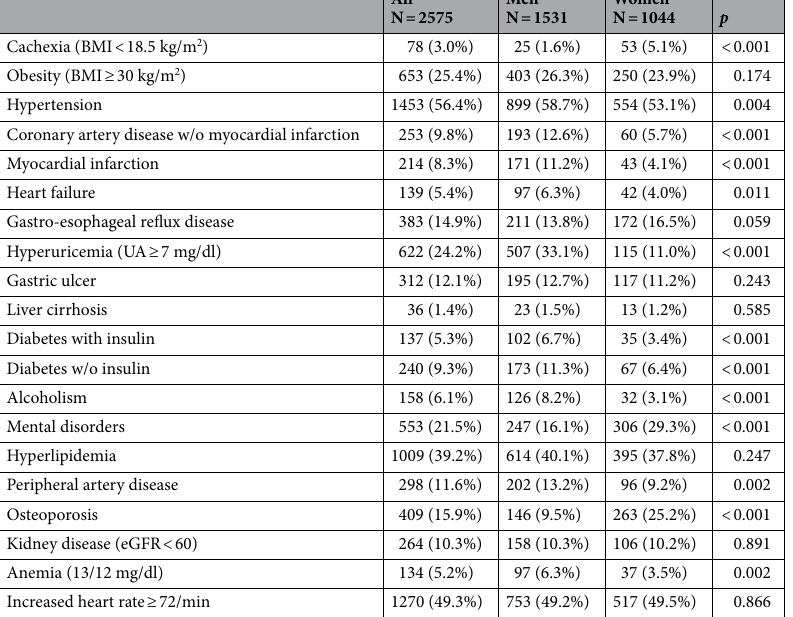
Table 2. Extra-pulmonary comorbidities. Absolute numbers and percentages are given. p values refer to the comparison between women and men and were derived from Chi-square statistics.